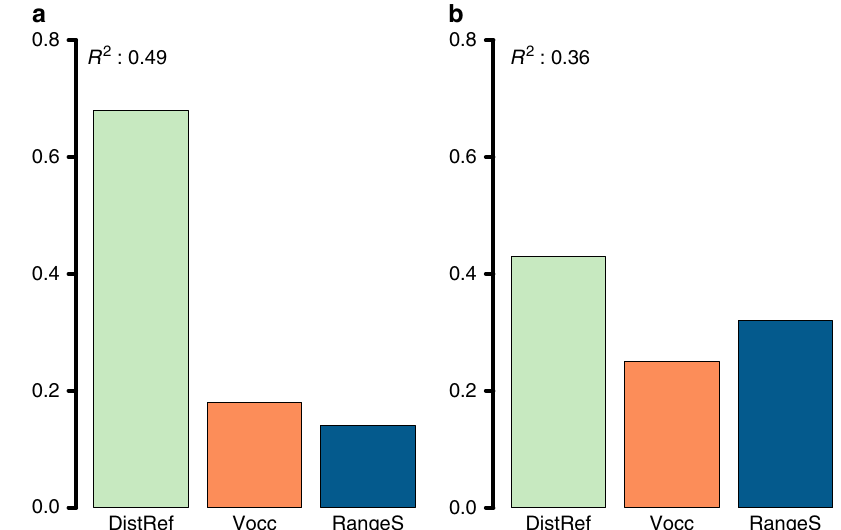
Fig. 2 Relative variable importance on phylo- β simC . a, b Variable importance of distance to refugia (DistRef), velocity of climate change (Vocc) and range size (RangeS), in explaining phylo- β simC for angiosperms ( a ) and gymnosperms ( b ). R 2 represents the model fi t of a standardized linear regression to explain phylo- β simC by means of DistRef, Vocc, and RangeS, (linear and quadratic terms). Relative variable importance was rescaled to sum to 1.0.